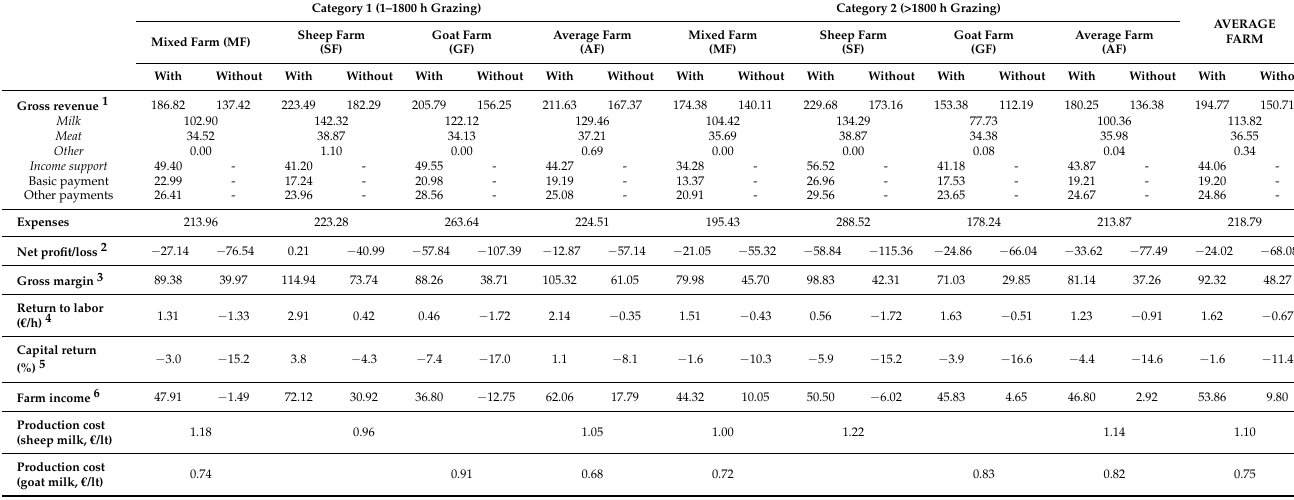
Table 4. Financial results of sample farms across Categories and types (with and without income support)